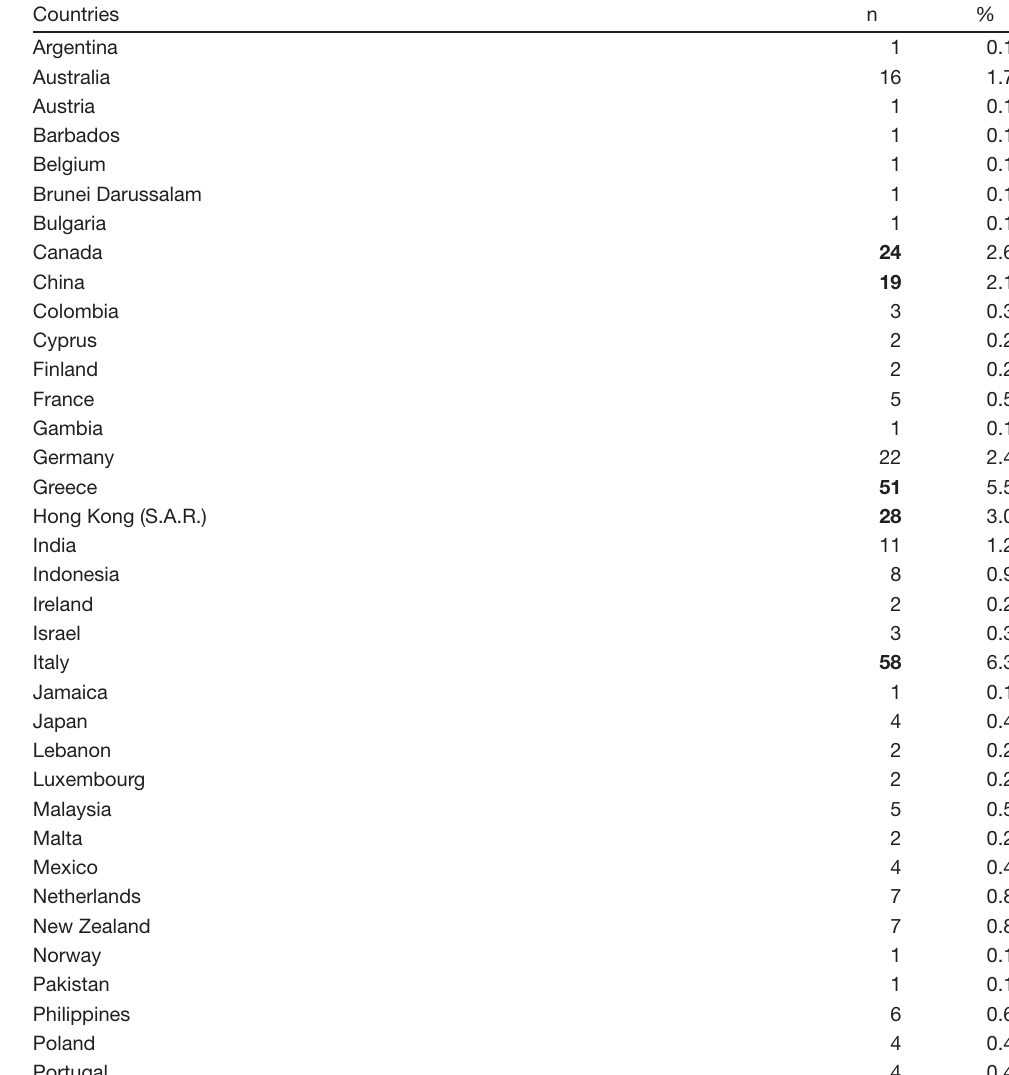
Table A1. Responses by